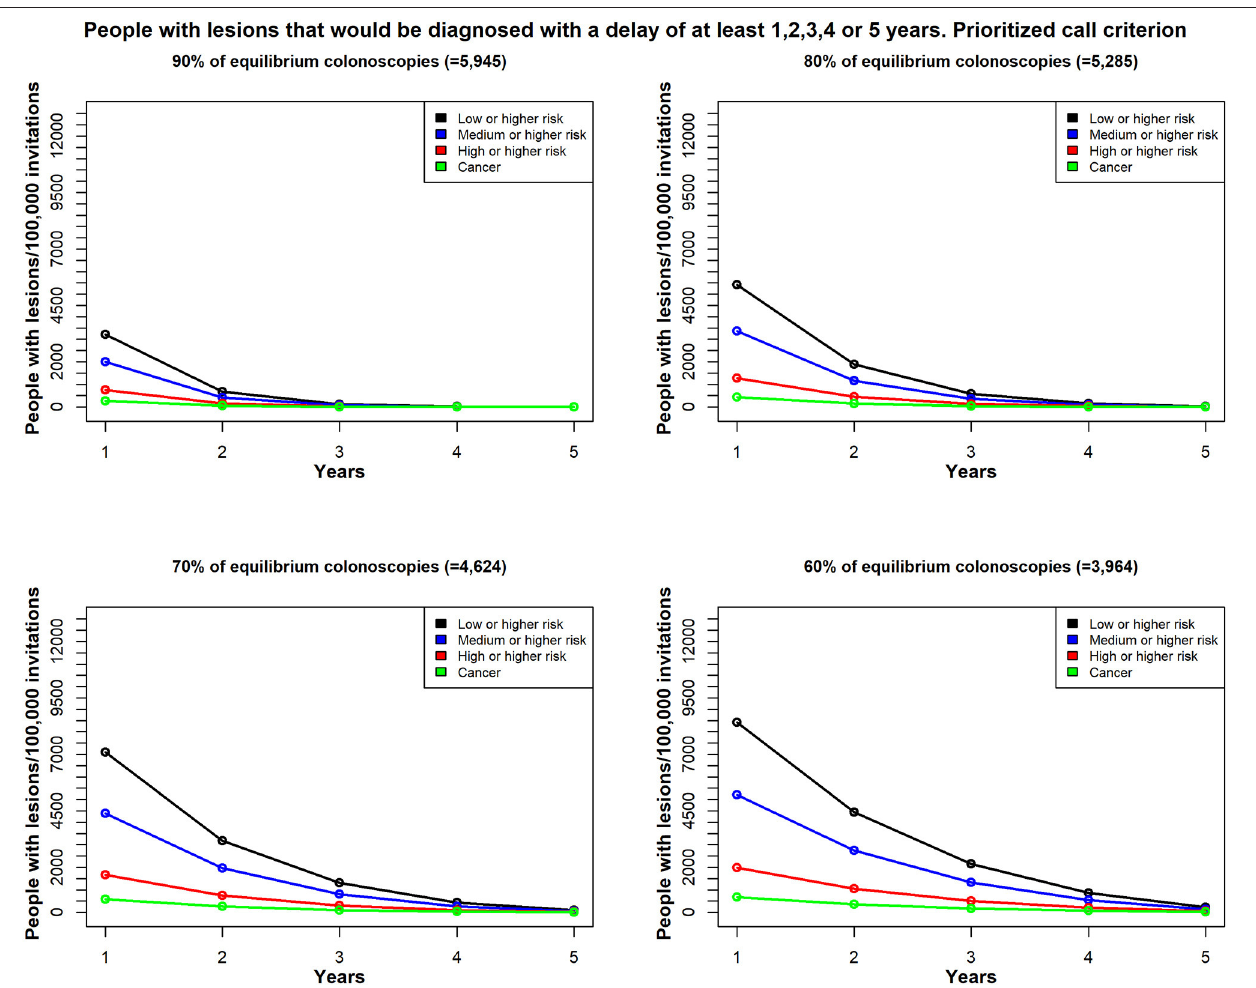
FIGURE 5 | In Scenario 1, the time delay, due to unavailable colonoscopies, for a diagnosis among patients with colorectal lesions in each risk class; patients were re-invited, based on the prioritized call by sex (men) criterion. Total demand for colonoscopies = 6,606/100,000 individuals per year; estimates reflect ( top left ) 90% availability ( n = 5,945); ( top right ) 80% availability ( n = 5,285); ( bottom left ) 70% availability ( n = 4,624); and ( bottom right ) 60% availability ( n = 3,964); Y-axis values reflect the estimated number of patients with lesions that would be diagnosed with a delay of at least 1 year, 2 years up to 5 years; X-axis values reflect the minimum delay